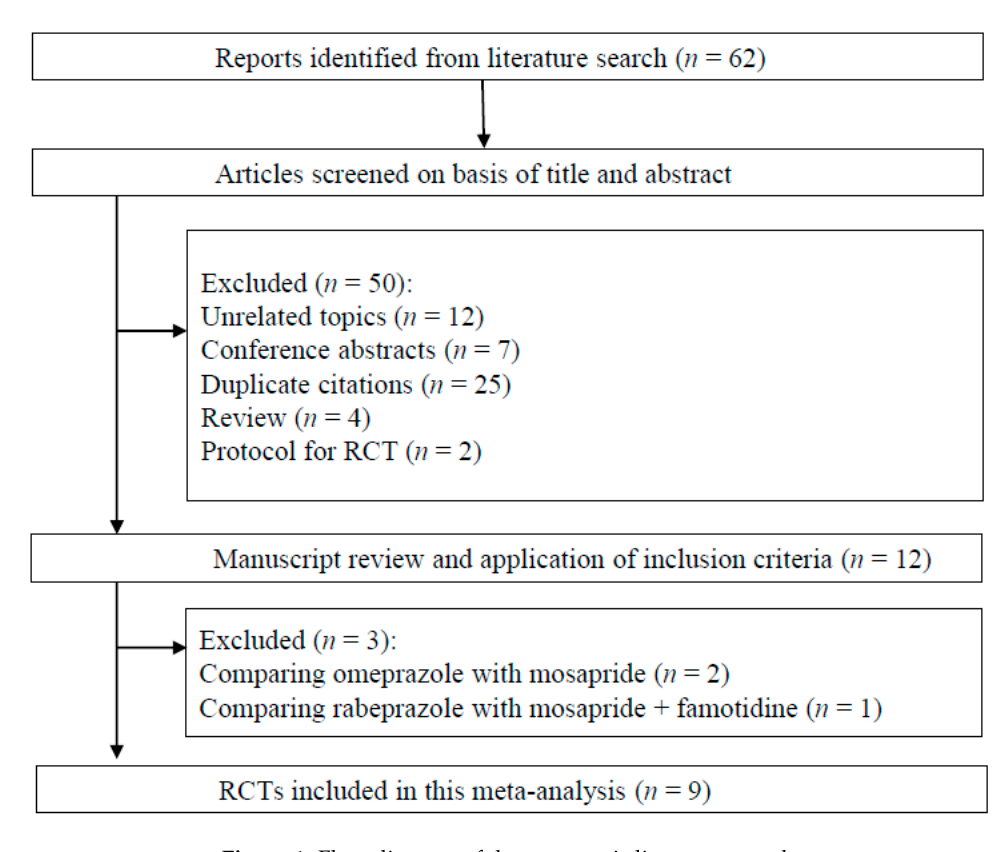
Figure 1. Flow diagram of the systematic literature search.